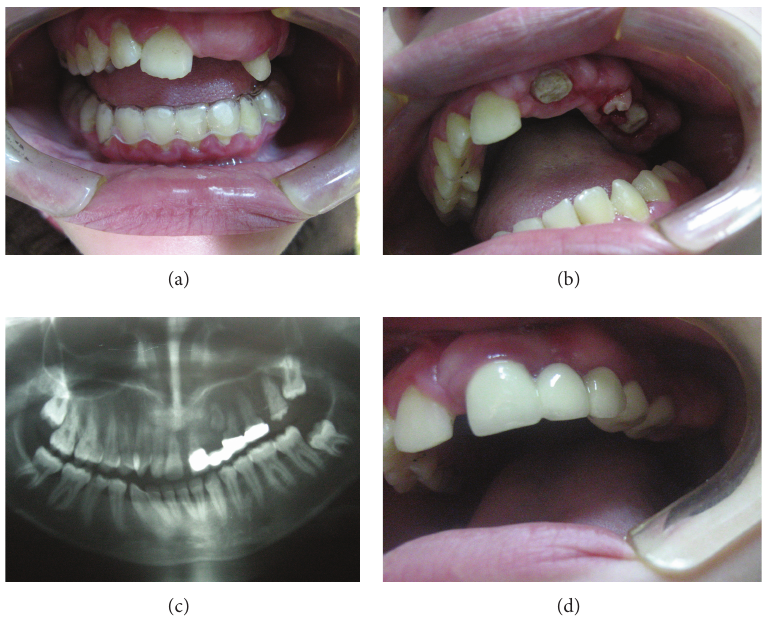
Figure 4: (a) Vacuum formed tray for the lower jaw to prevent overeruption of lower teeth. (b) Surgical exposure of the impacted teeth. (c) Panoramic view for the case after surgical exposure and placement of the porcelain fused to metal bridge. (d) Final oral condition at 17 years of